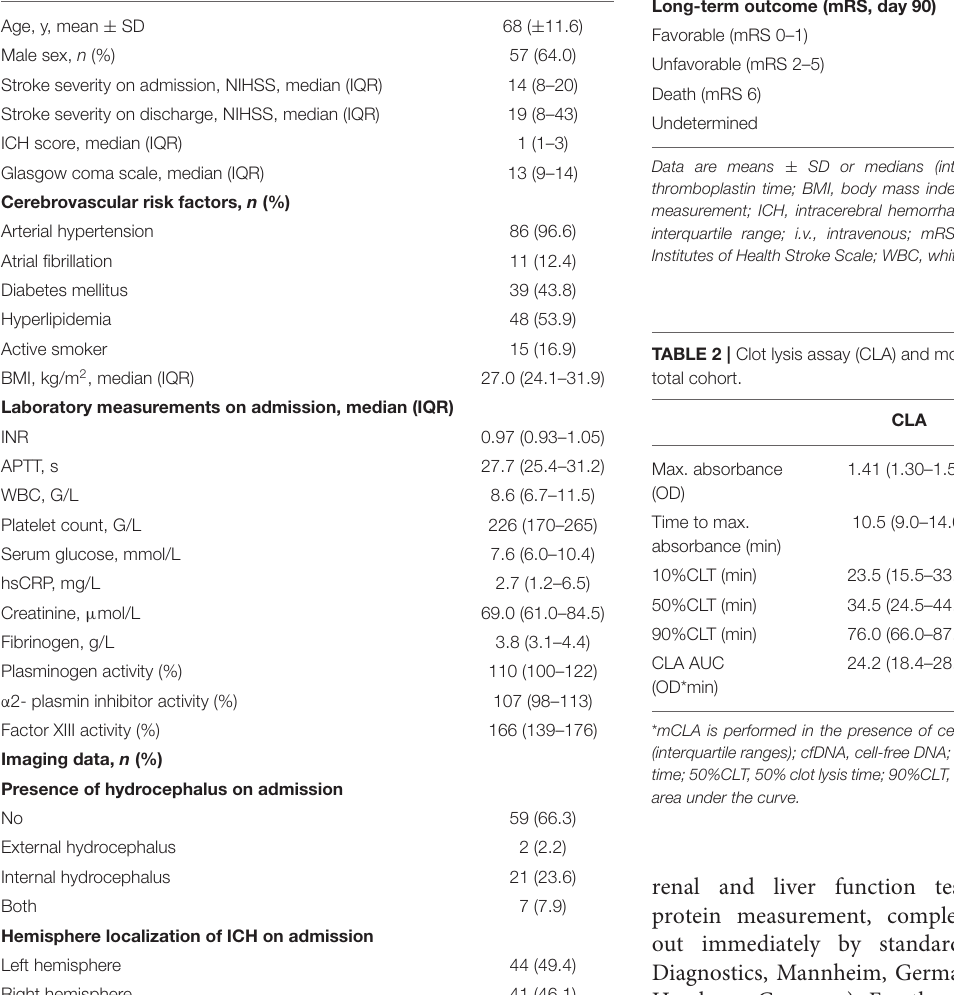
TABLE 1 | Baseline characteristics of enrolled patients, imaging data and outcomes. Number of patients,